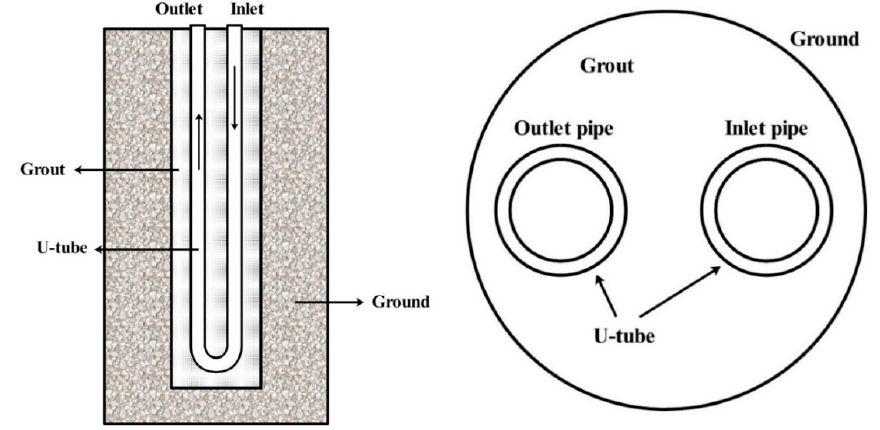
Figure 1. Schematic diagram of a single U-tube borehole heat exchanger.